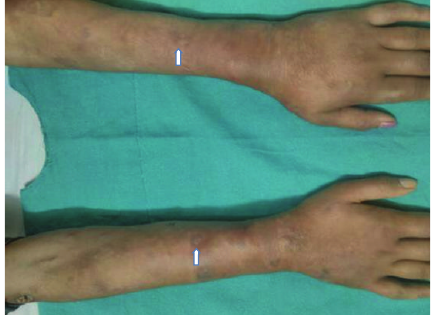
Figure 2: Picture of forearms and hands showing papulonodular infiltrating erythematous lesions over the forearms and dorsum of hands (white arrows).